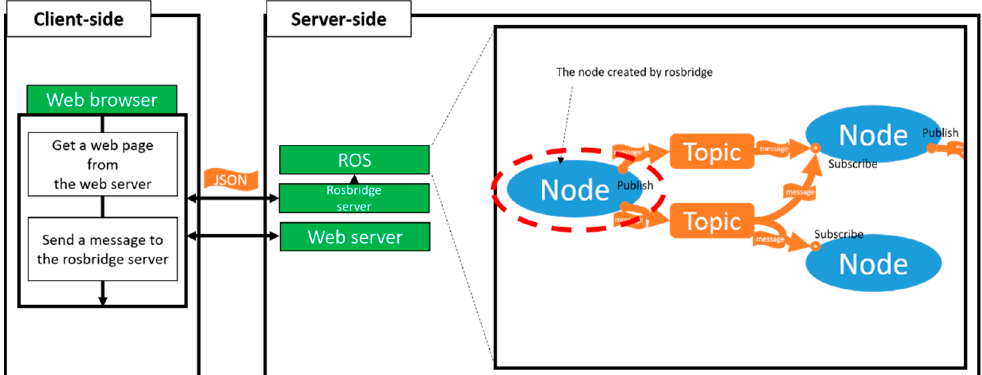
Figure 5. Rosbridge concept.